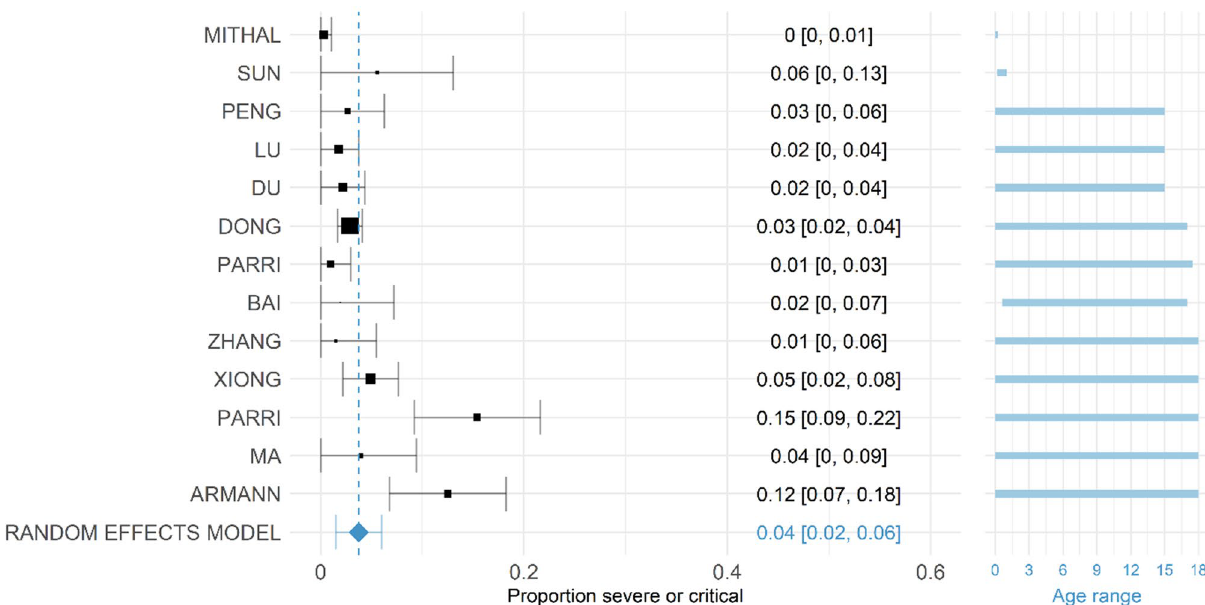
Figure 4. Proportion of COVID-19 positive children who were defined as severe or critical in each available study. The random effects model result is given at the bottom indicated by a blue diamond. The squares are proportional in size to the number of COVID-19 positive individuals in the study. All studies were conducted in 2020. The labels on the left provide first author, the labels on the right give point estimate and confidence interval of the proportion. Studies are ordered by the mean of the age range with age range given in blue on the right.